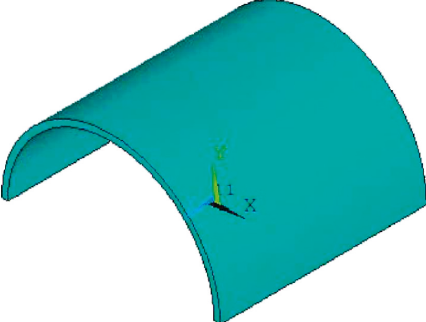
Figure 6: Cylindrical coil